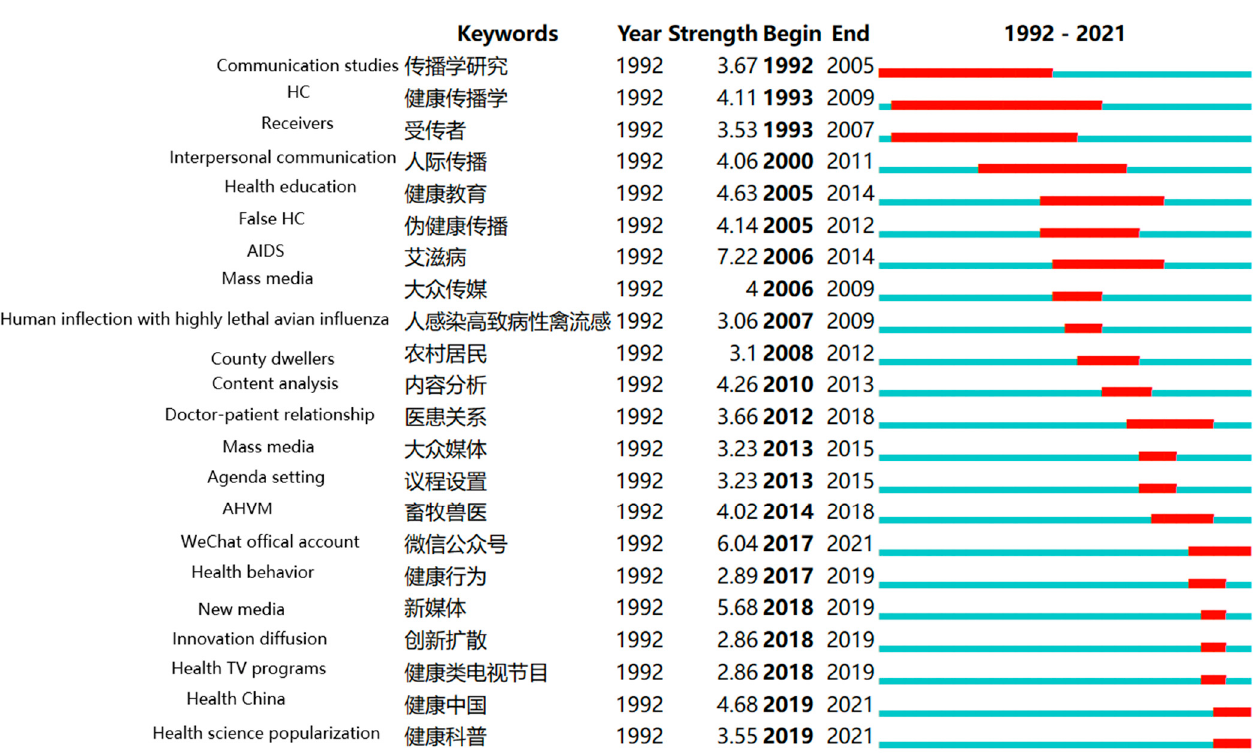
Figure 7. Top 22 keywords with the strongest citation bursts in HC research between 1992–2021. (Note: red shows the period of the detected term burst, while blue presents the time. The authors added English to the map to aid understand ‐ ing.)